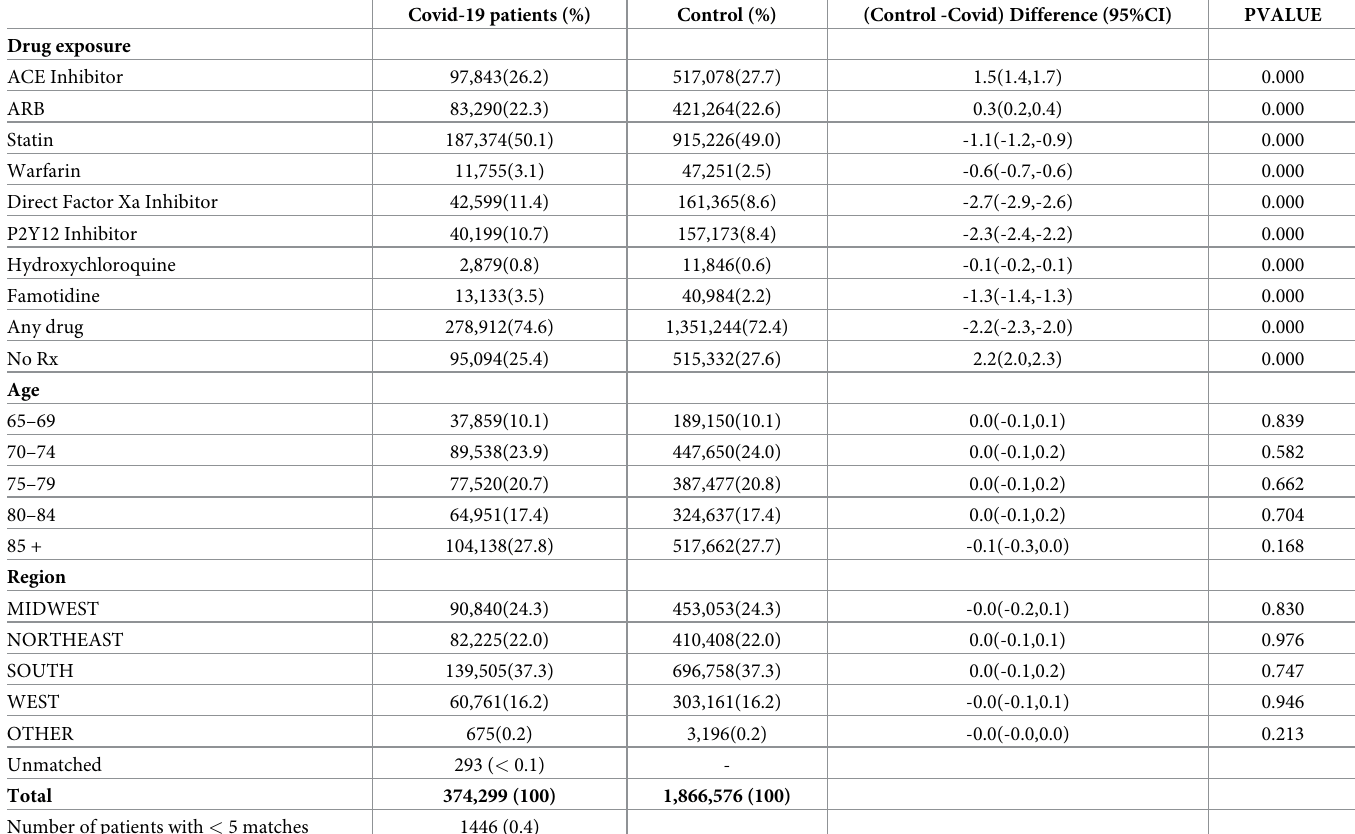
Table 2. Characteristics of Covid-19 patients and matched